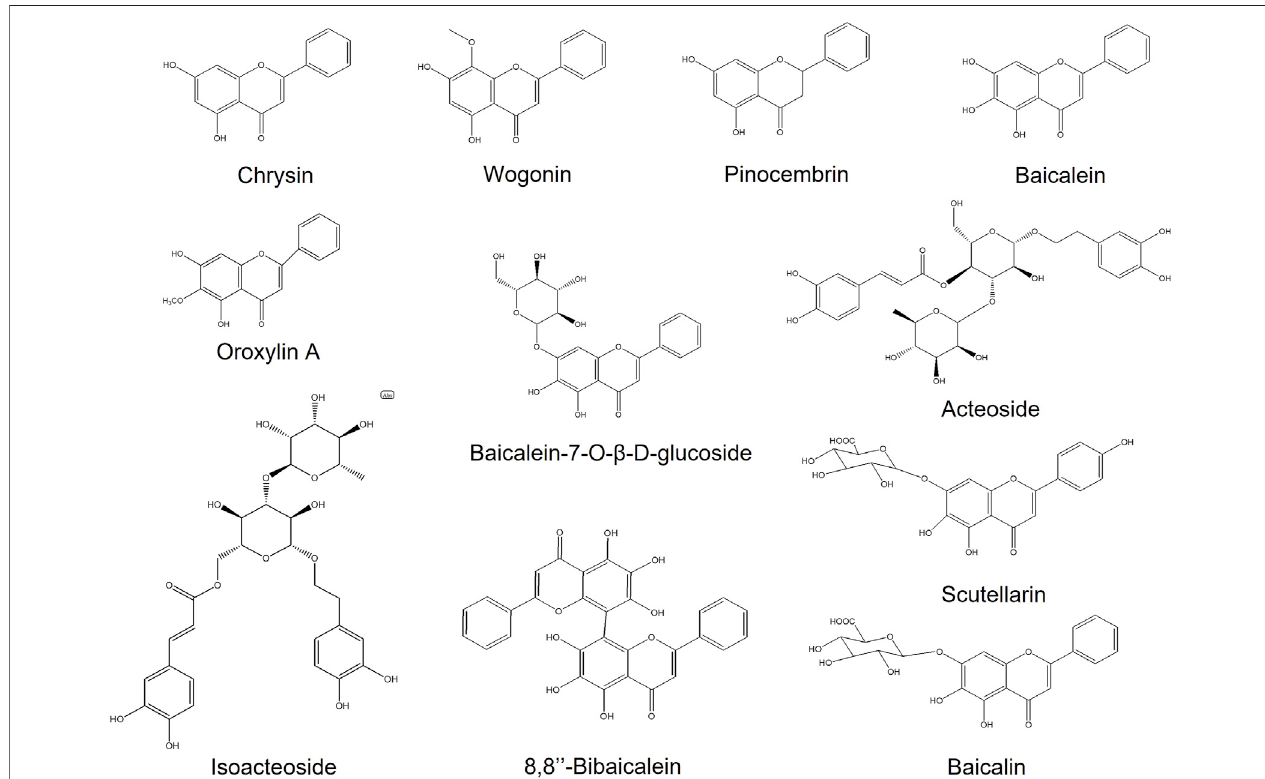
FIGURE 2 | Chemical structures of components with correlation coef fi cient ≥ 80 in the positive or negative mode.